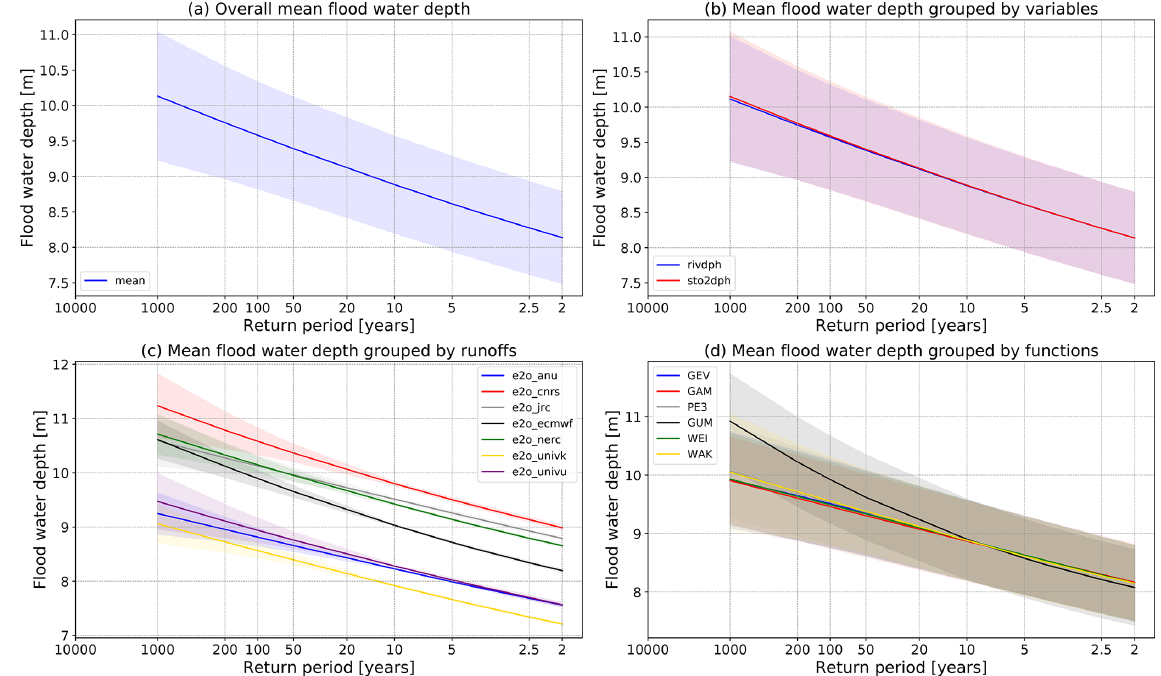
Figure 6. The uncertainties in the estimated flood water depth at Phnom Penh (104.9317 ◦ E, 11.5617 ◦ N) in the Mekong River basin in different groups. (a) The mean flood water depth and overall uncertainty. (b) The mean and uncertainty in groups of different variables for FFA; the uncertainty is then not related to the selected variable. (c) The mean and uncertainty in groups of different runoff inputs. (d) The mean and uncertainty in groups of different fitting distributions.